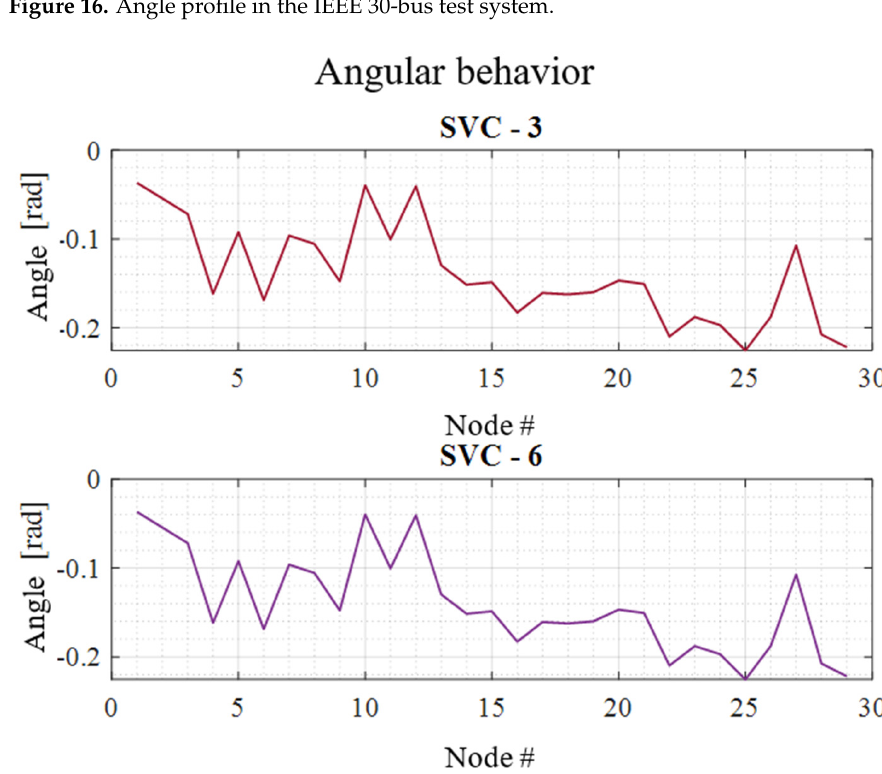
Figure 17. Angle profile in the IEEE 30-bus test system: SVC 3 and 6.